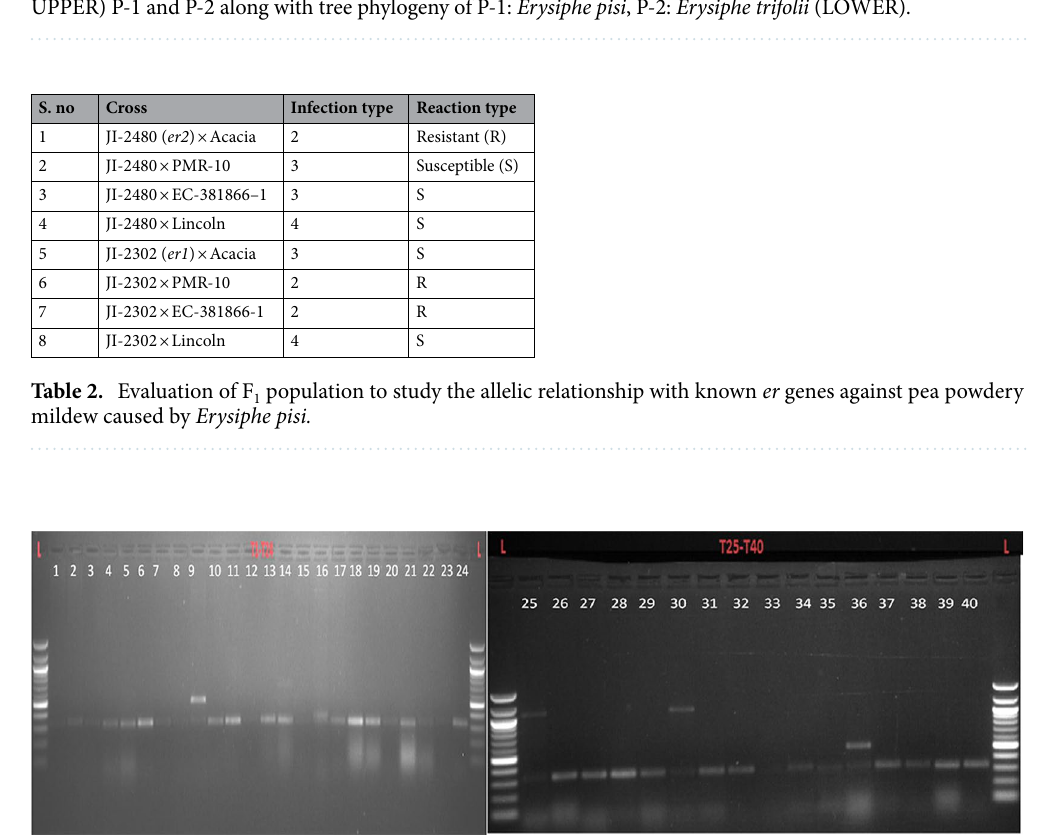
Figure 2. rDNA region amplified using Erysiphe specific primers-EryF(5’-TAC AGA GTG CGA GGC TCA GTCG-3’) EryR (5’-GGT CAA CCT GTG ATC CAT GTG ACT GG-3’) (M: 1 Kb ladder; fungal isolates (P1-P24 UPPER) P-1 and P-2 along with tree phylogeny of P-1: Erysiphe pisi , P-2: Erysiphe trifolii (LOWER).